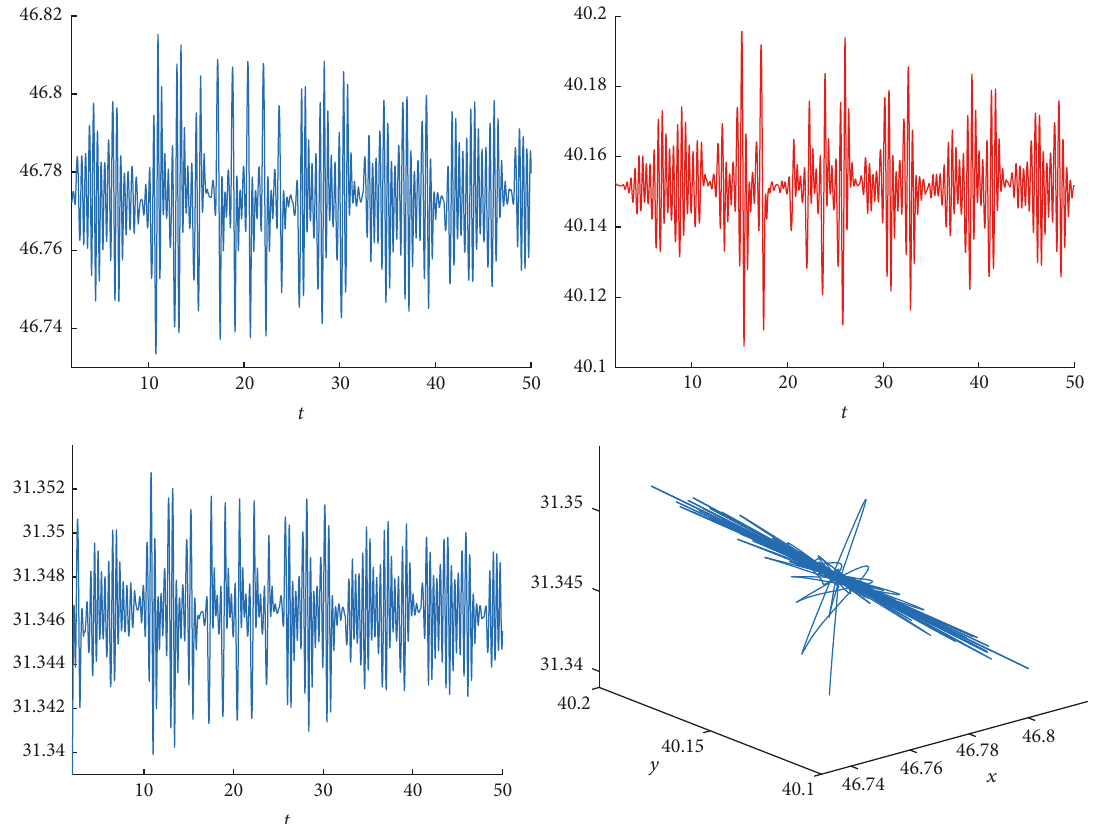
Figure 3: Dynamical behaviors and phase space trajectories of the three fish